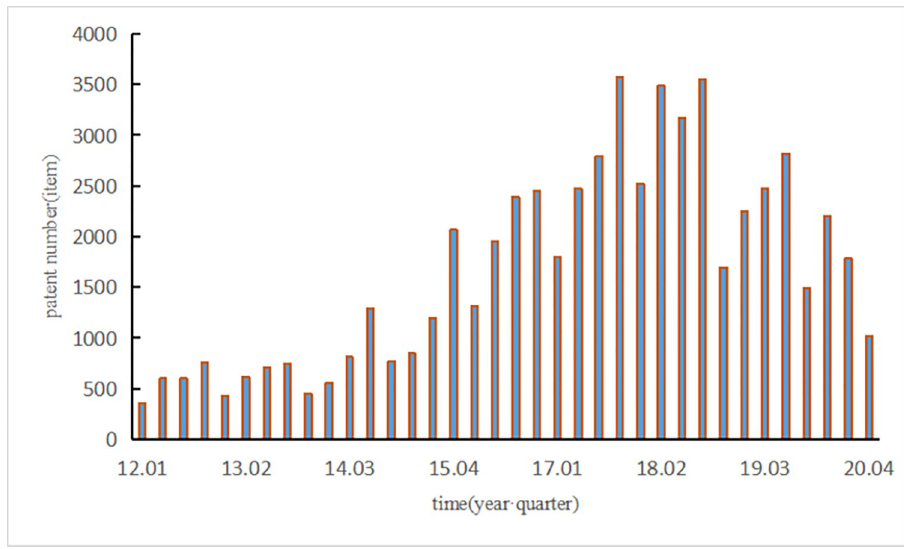
Fig 4. Number of patent applications in each quarter from 2012 to